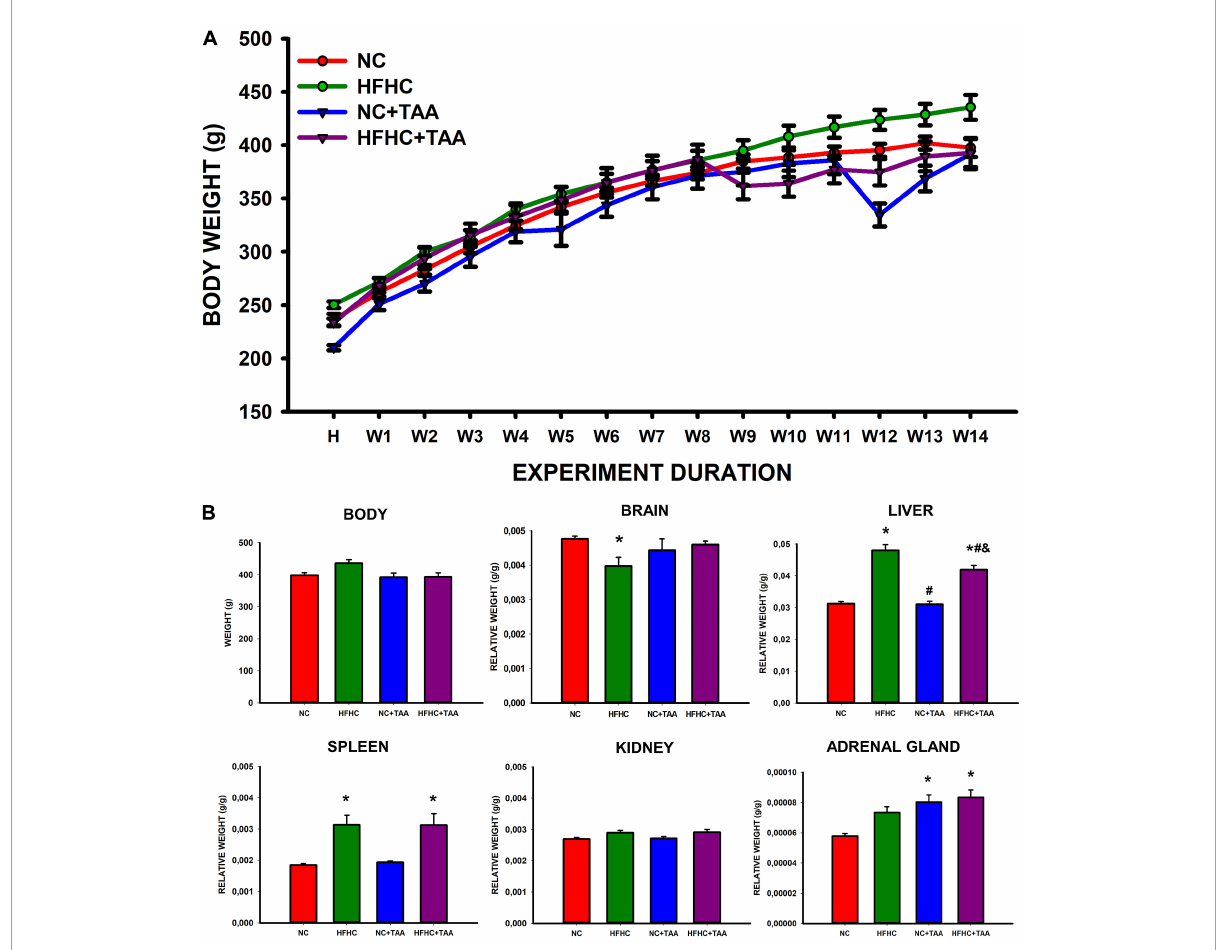
FIGURE2 Body and organs weight. (A) Body weight across experimental weeks. The Scatter plot (mean ± SEM) represents body weight, which was compared through a two-way repeated-measures ANOVA (group X week). H, habituation week; W, week. No differences were found between the groups, but the weight increased significantly across the weeks ( p < 0.001). No statistically significant differences were neither observed in the final body weight when compared through a one-way ANOVA. (B) Body and organs relative weight. Bars charts (mean ± SEM) represent body weight (g) as well as the brain, liver, spleen, kidney, and adrenal gland relative weight (g/g) (organ weight/body weight) compared through a one-way ANOVA followed by Tukey’s test (*comparison with NC, # comparison with HFHC, & comparison with NC + TAA; * #& p <